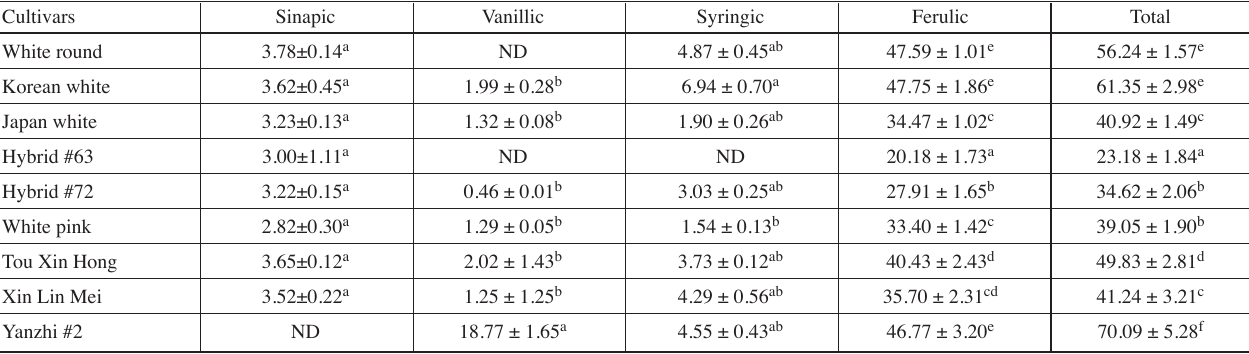
Tab. 4: Free phenolic acids in radish seeds 1